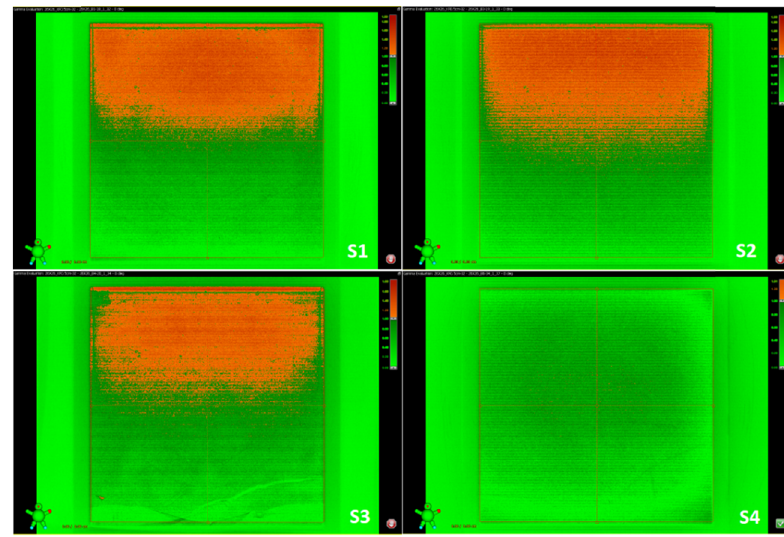
Figure 4: Blended view of gamma analysis results of the 0.5 cm thick bolus samples and R0.5 for 0.5%/0.5 mm criteria ( from upper left to right S1, S2, S3 and S4, respectively )